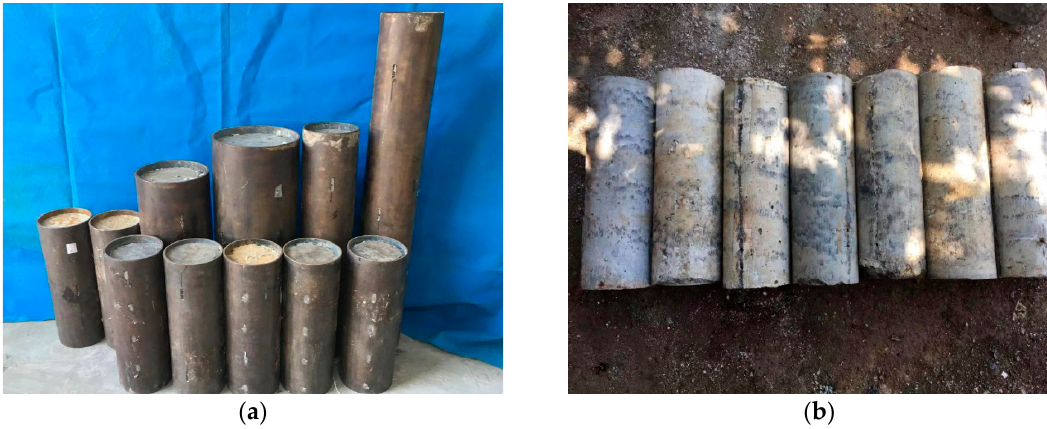
Figure 5. Typical failure mode of specimens. ( a ) Failure mode of all specimens; ( b ) The core concrete taken out from partial CFT-PAC columns.